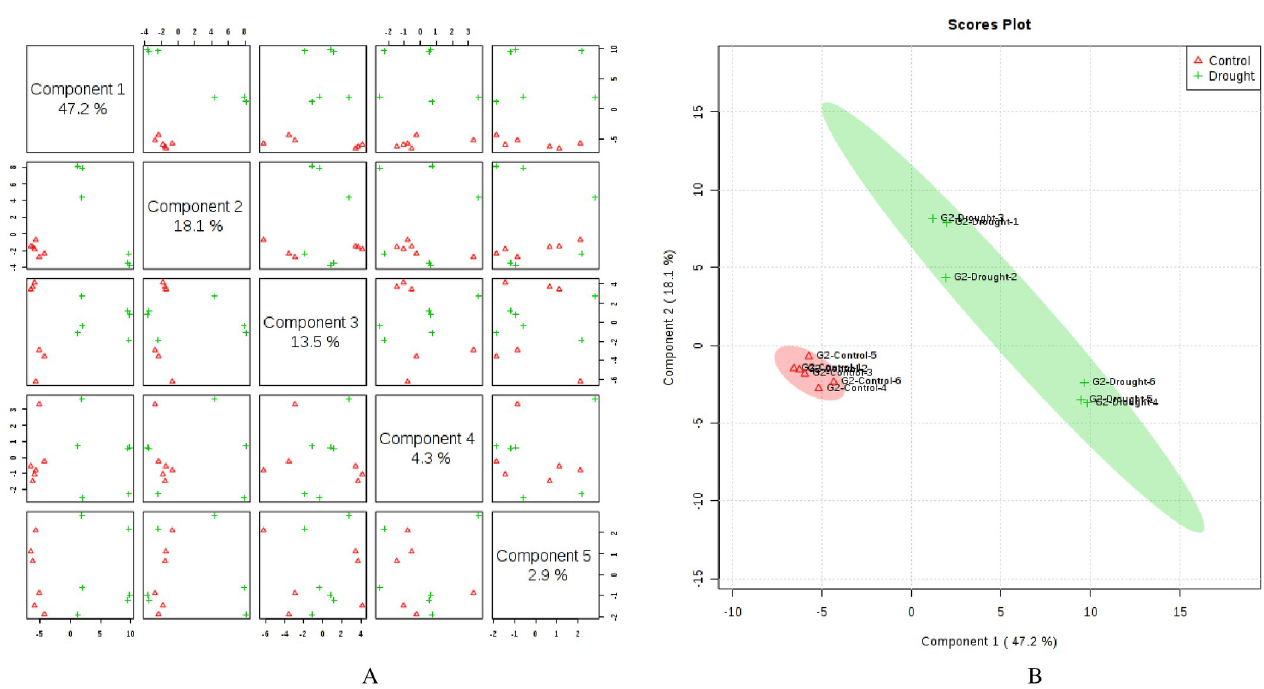
Fig 3. Partial least square discriminant analysis (PLS-DA) (A) and 2D Scores plot (B) in flag leaves of AGS2038 under control (irrigated) and drought conditions. Samples at control and drought treatments did not overlap with each other indicating an altered state of metabolite levels in the wheat leaves.